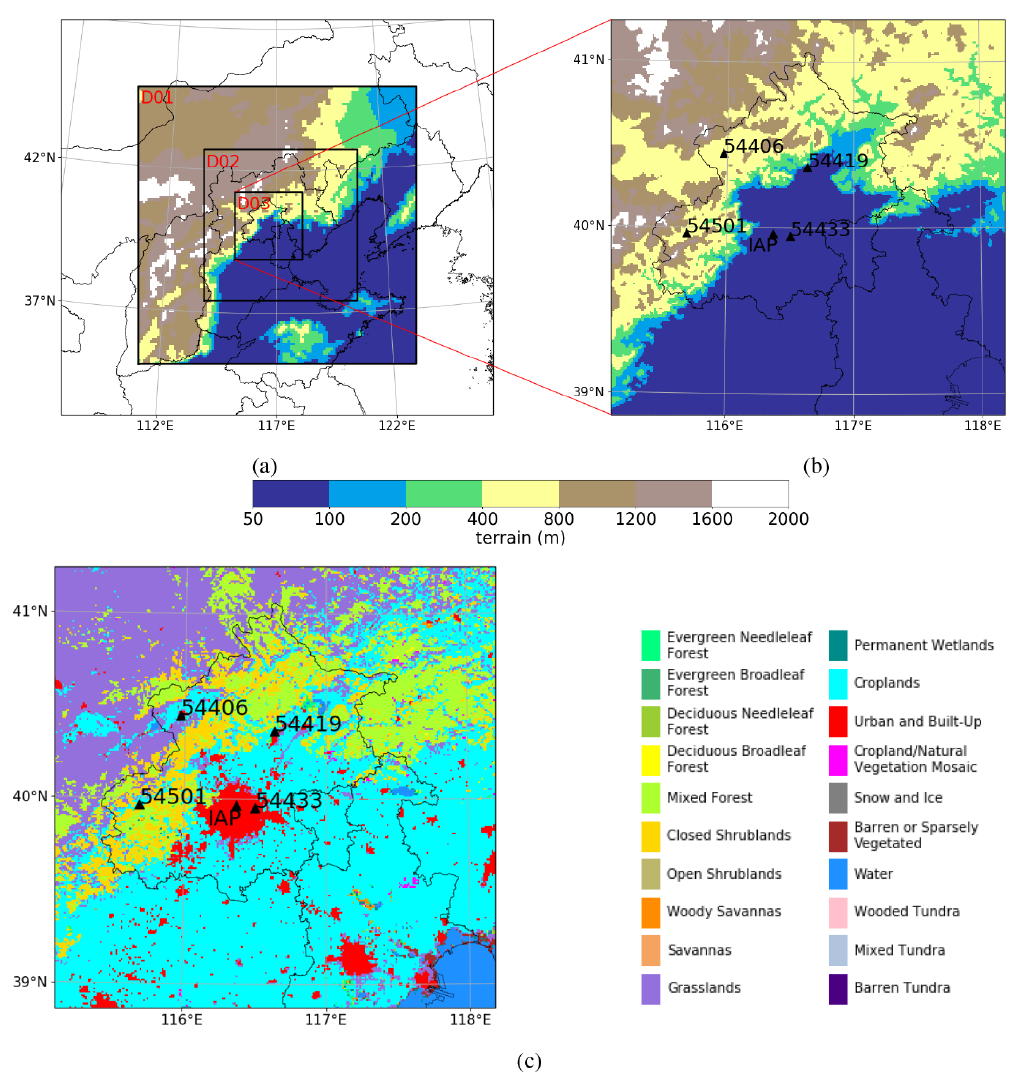
Figure 1. (a) Description of the locations of three nested domains, (b) an enlarged drawing of the terrain belonging to the innermost domain (i.e., D03), and (c) the spatial distribution of the land-use categories within D03. Locations of the IAP station and the four automatic weather stations (nos. 54433, 54406, 54419, 54501) are also marked in (b) and (c)